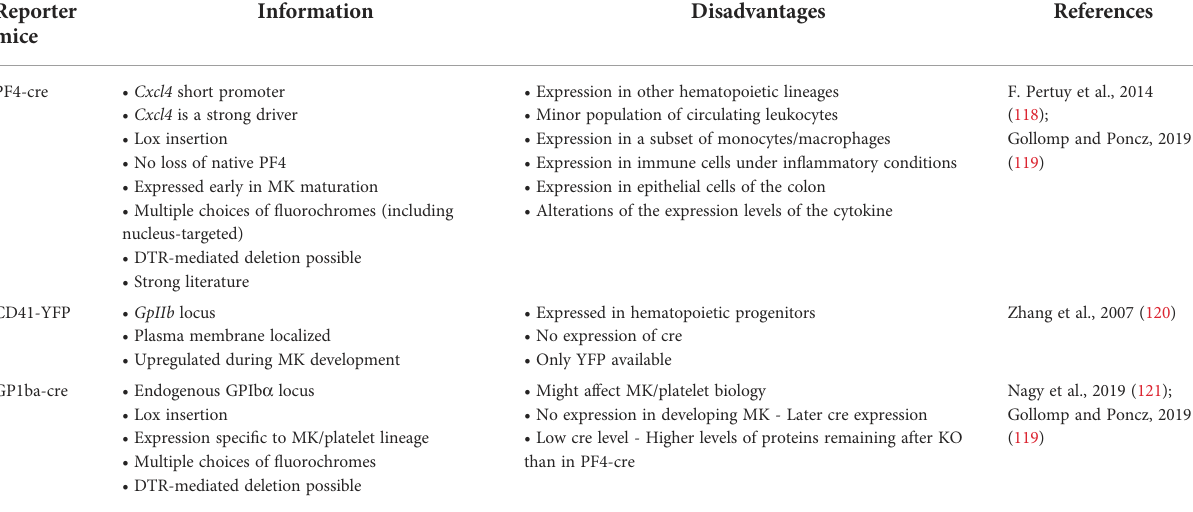
TABLE 3 Comparison of MK/Platelet reporter mice.